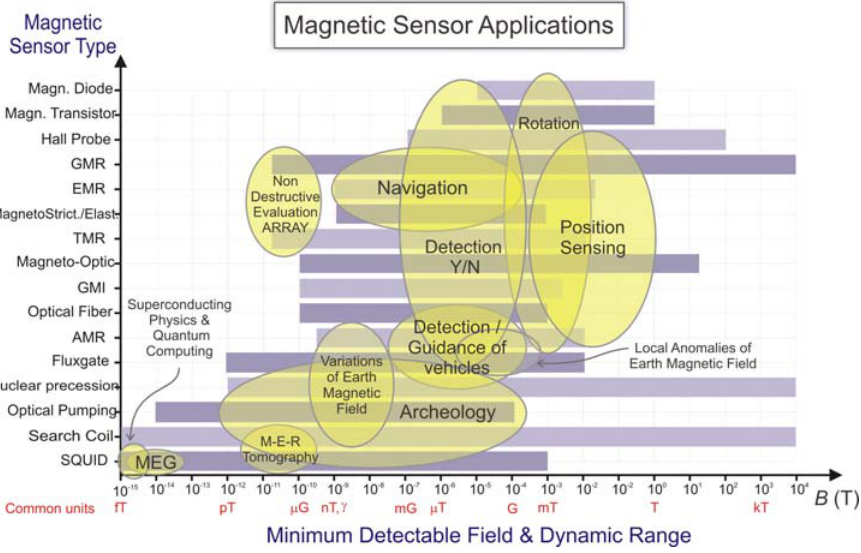
Figure 1. Magnetic Sensors Technologies: Magnetic properties (dynamic ranges and detectivities) and